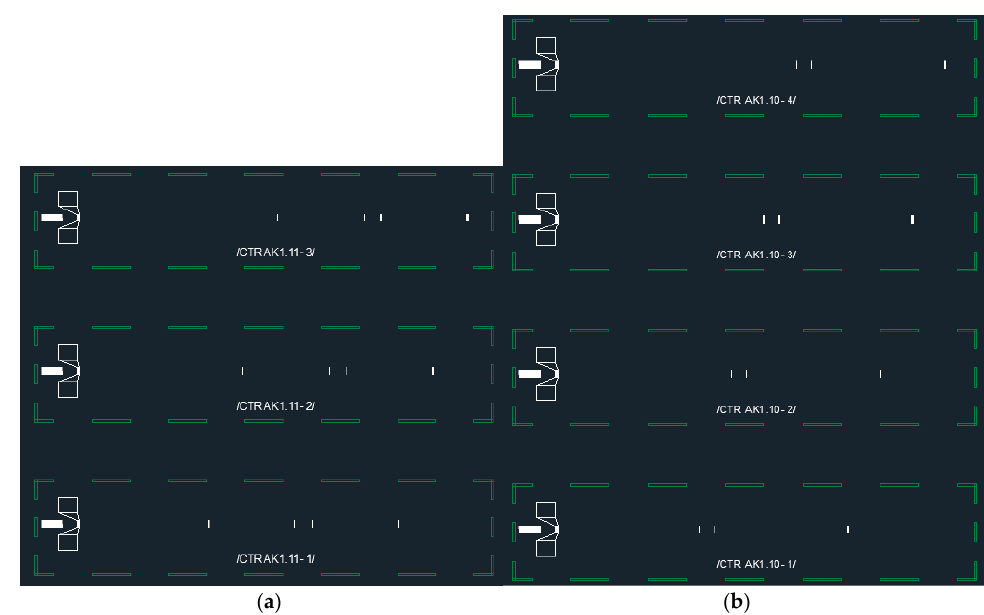
Figure 2. Mask design of two different multi sensor layouts based on reflective delay lines: The IDT structure where the SAW is generated can be seen to the very left of each device where the square wire bond pads are shown as well. The reflectors that correspond to the sensor peaks are visible as short white vertical lines. The white structure on the left of the IDT is a sink, which dampens the part of the wave emitted to the left side and thus reduces reflections from the edges of the die. ( a ) Design A: four peak design for three sensors. ( b ) Design B: three peak design for four different sensors.